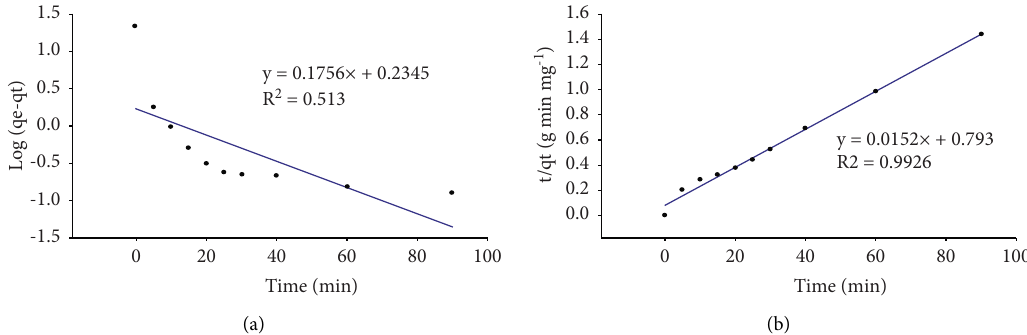
Figure 5: Kinetics of Zn(II) adsorption by D. tsuruhatensis SA-101: (a) pseudo-frst-order; (b) pseudo-second-order. Table 4: Kinetic parameters obtained from Zn(II) biosorption by D. tsuruhatensis SA-101 based on the pseudo-frst-order and pseudo-second-order models. Initial conc. q exp